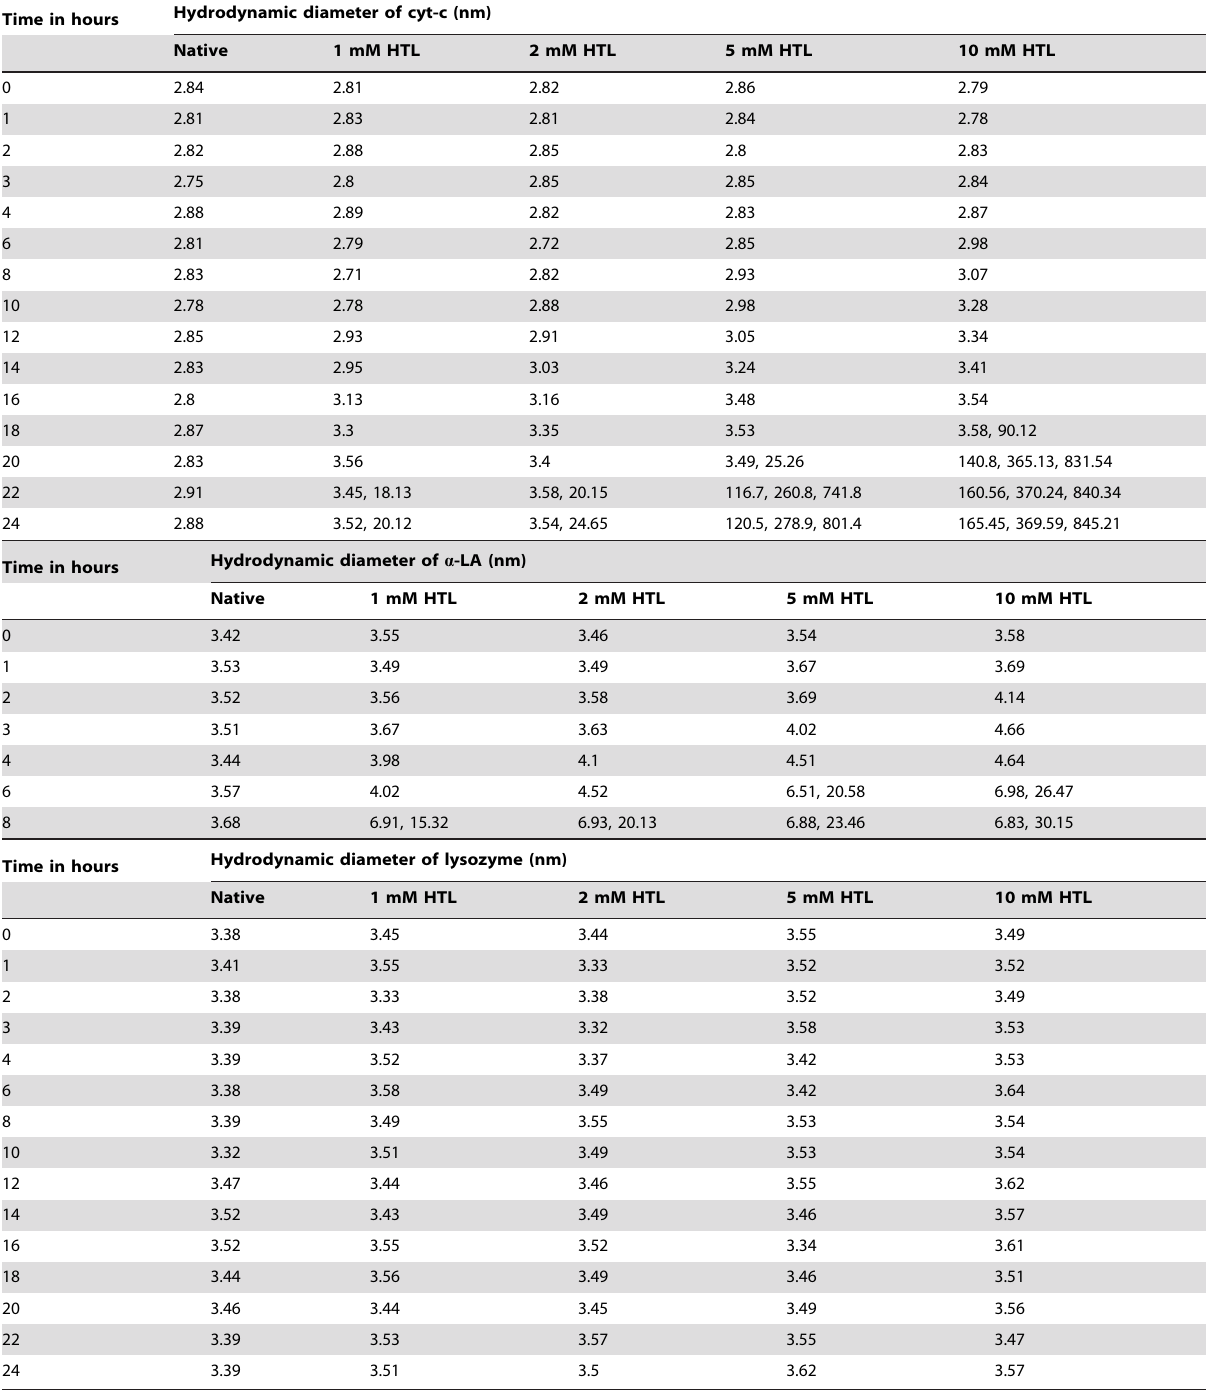
Table 1. Hydrodynamic diameter of cyt-c, a -LA and lysozyme*.